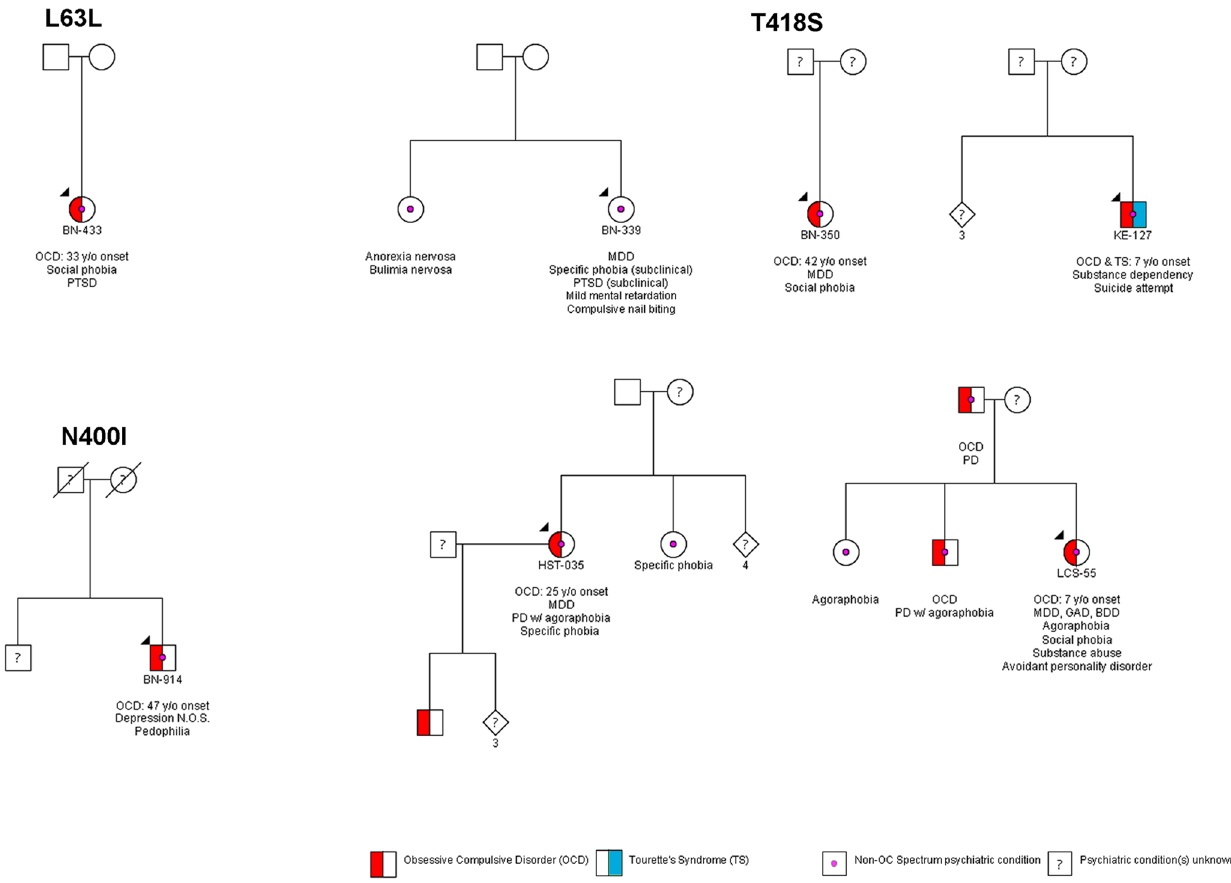
Figure 2. Pedigree diagrams of families with SLITRK1 variants. Pedigrees for individuals in whom SLITRK1 variants were identified. Each obsessive-compulsive (OC) spectrum proband is labeled with his/her identifier and is designated by a black arrowhead. Individuals affected with an OC spectrum disorder are represented by shaded symbols, with red shading indicating obsessive-compulsive disorder (OCD) and blue shading indicating Tourette syndrome (TS). Psychiatric conditions outside of the OC spectrum are represented by a magenta circle in the center of the symbol. Male family members are represented with squares, females with circles, persons with unspecified gender are diamonds with the number of individuals indicated directly below. All psychiatric pathology is listed under each affected individual. OCD – Obsessive-Compulsive Disorder, TS – Tourette syndrome, BDD – Body Dysmorphic Disorder, GAD – Generalized Anxiety Disorder, MDD – Major Depressive Disorder, N.O.S. – not otherwise specified, PD – Panic Disorder, PTSD – Post-Traumatic Stress Disorder, w/ - with, y/o – years old, ? – psychiatric history is unavailable for the individual.